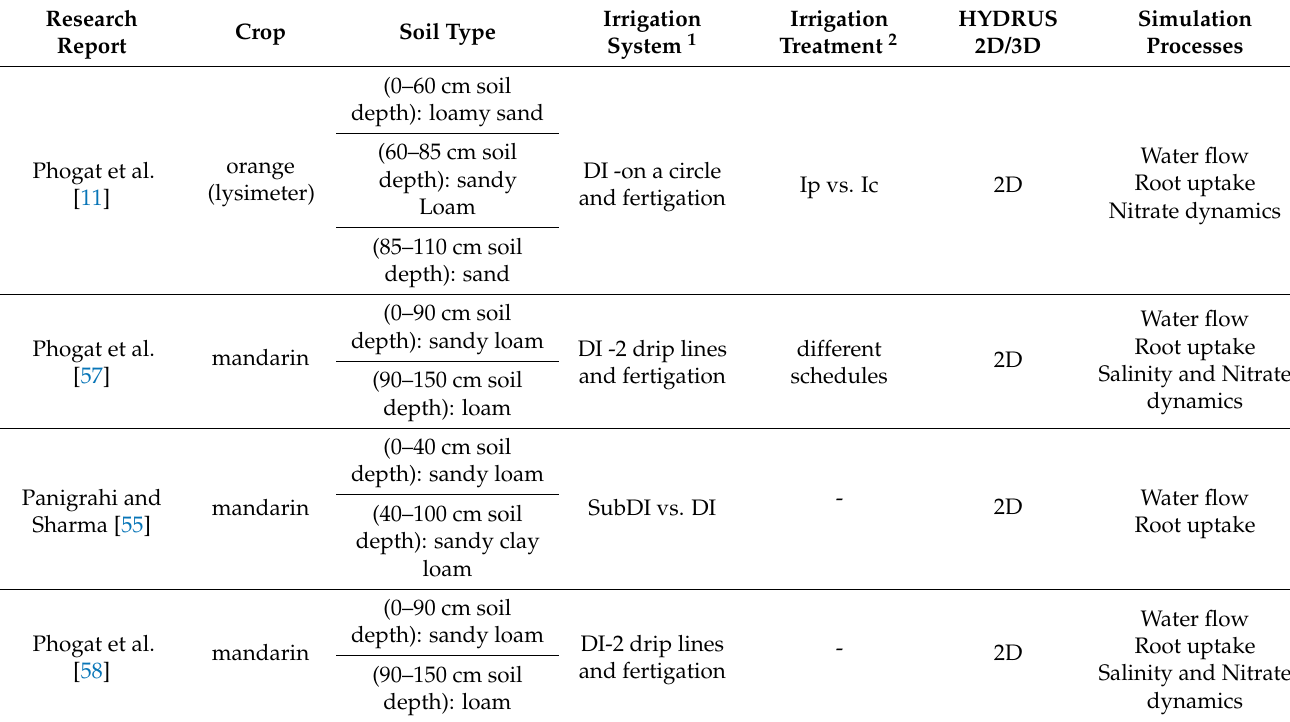
Table 1. Summary of HYDRUS 2D/3D simulations in citrus